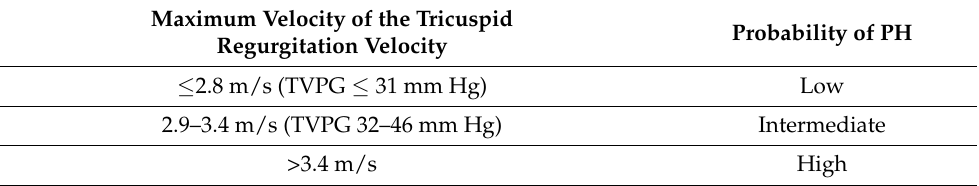
Table 2. Probability of pulmonary hypertension (PH), stratified by echocardiography